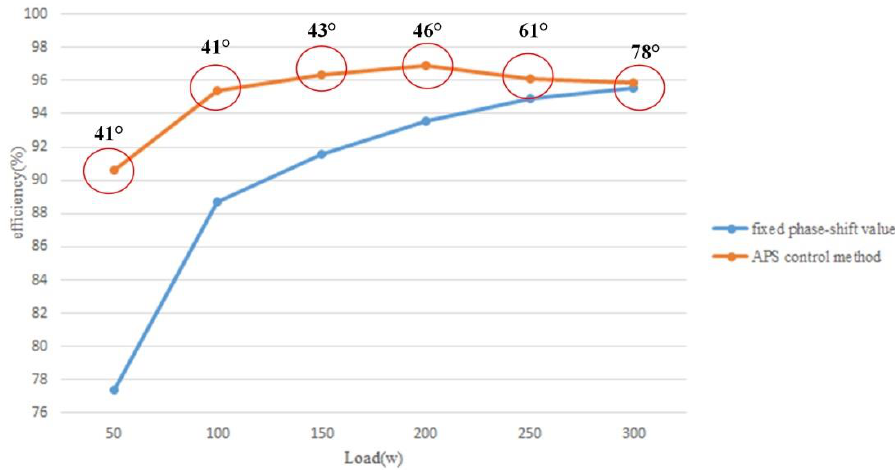
Figure 23. Measured efficiency curves of different control methods under buck-discharging mode.